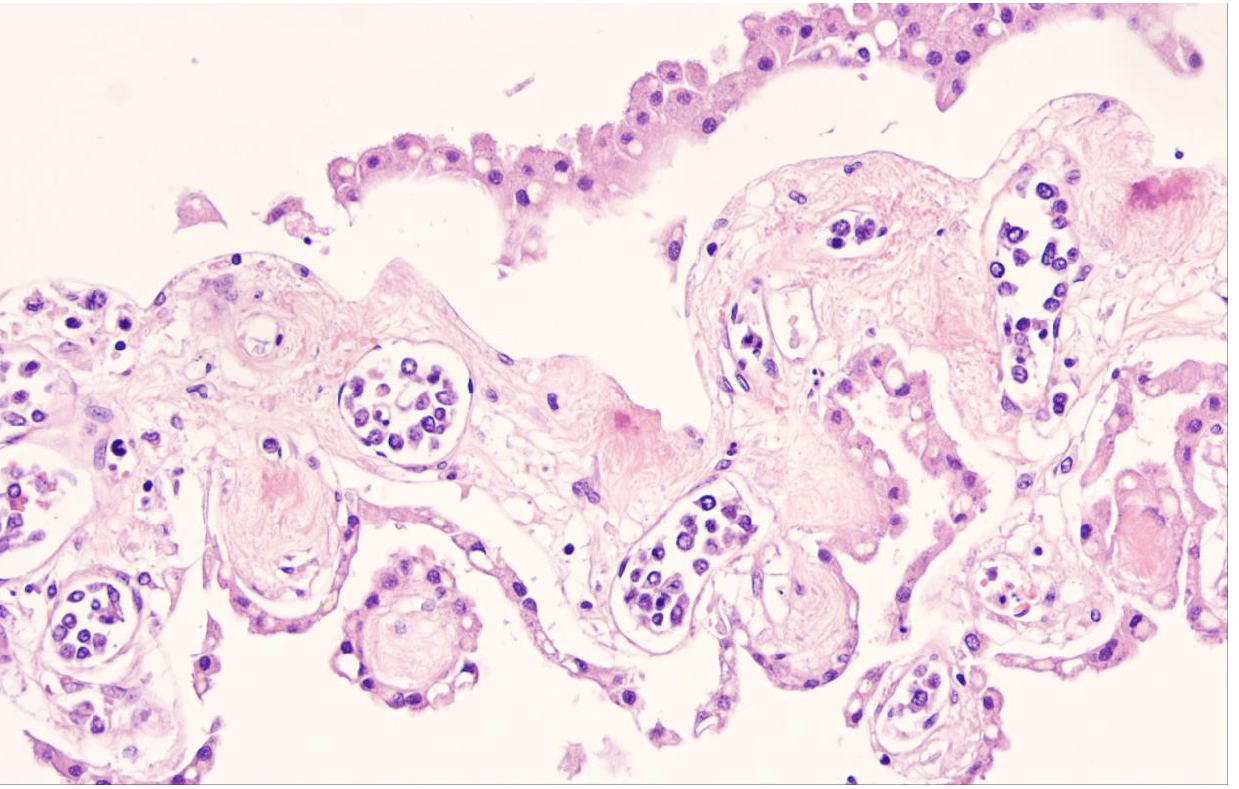
Figure 13. Intravascular large B-cell lymphoma (H&E ×200). The typical blastic tumor cells are seen within distended capillary vessels of the leptomeninx.